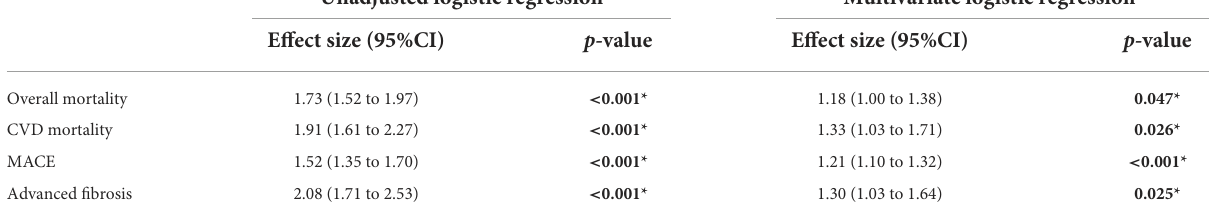
TABLE 2 Effect size of adverse events in NAFLD individuals with poor weight perception with reference to NAFLD individuals without poor weight perception. Unadjusted logistic regression